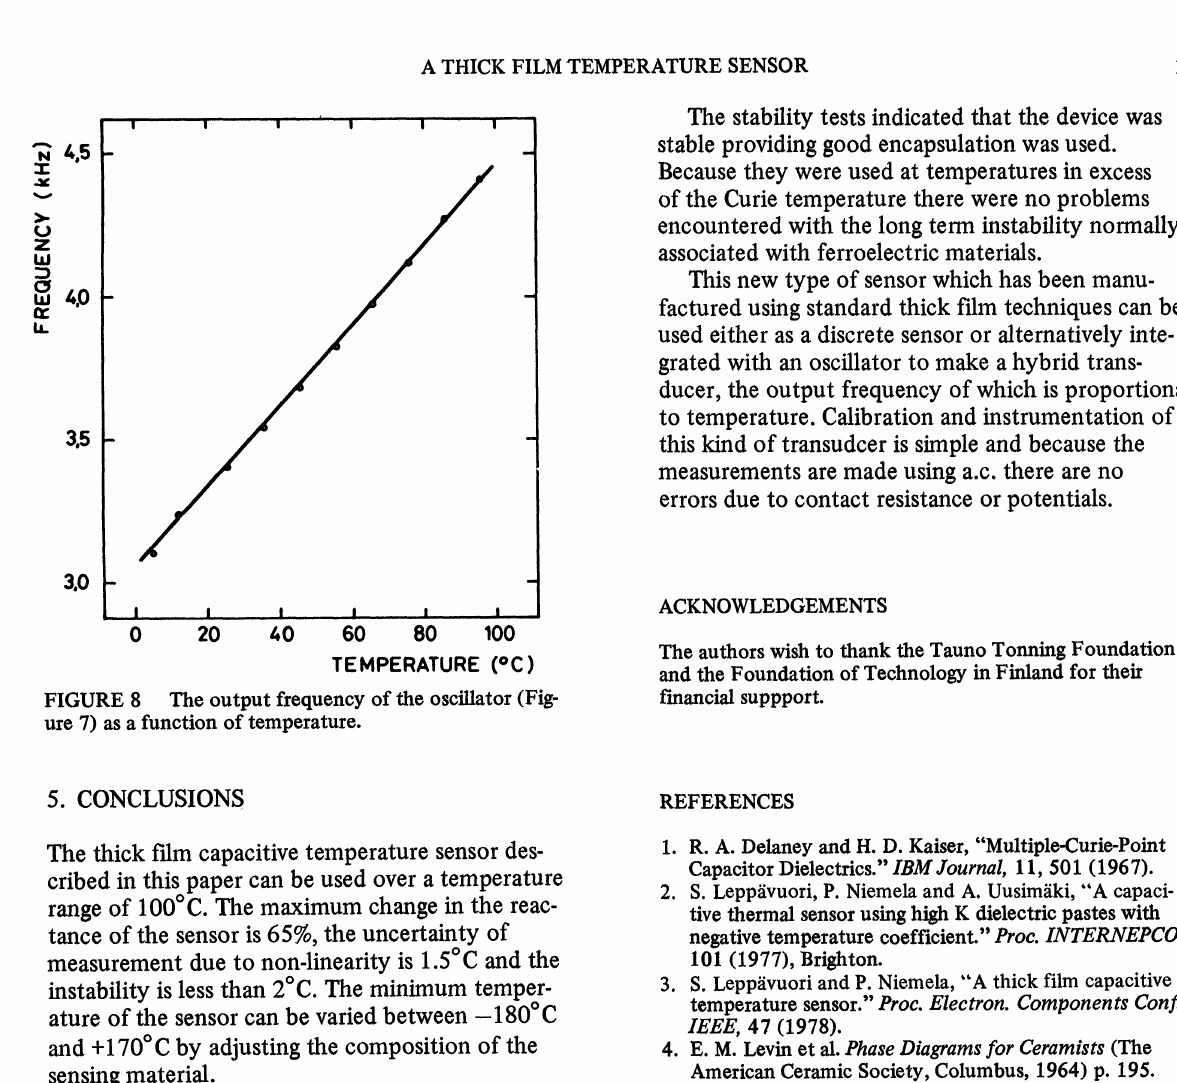
TABLE II Properties of the